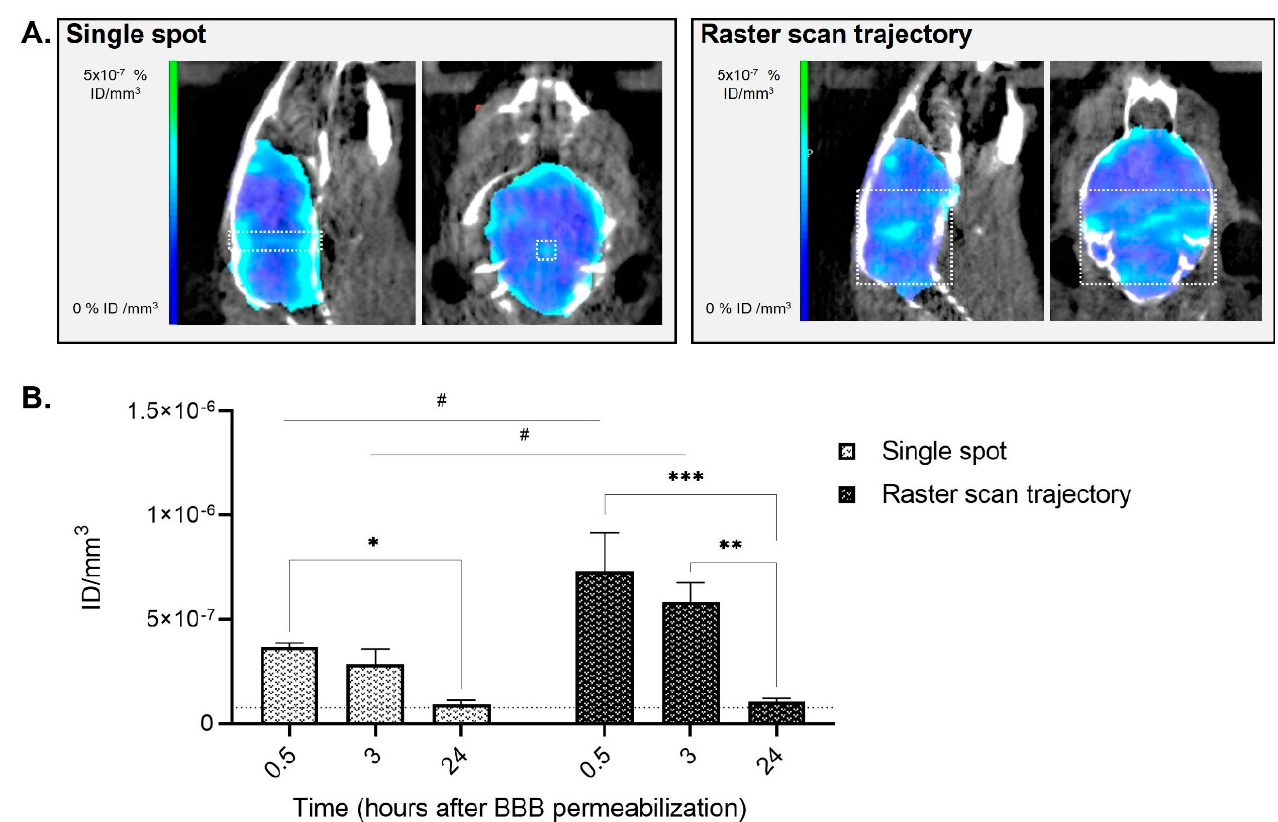
Figure 2. Imaging of the animal’s brain following BBB disruption and [99mTc]Tc-DTPA intravenous injection in healthy mice 0.5 h later. ( A ) Brain representative SPECT/CT tomographic images of [99mTc]Tc-DTPA distribution in animals that received single-spot (group A, left panel) or raster scan trajectory (group B, right panel) focused ultrasound. The white square represents the approximate region were FUS were applied for both sonication schemes; ( B ) Quantification of [99mTc]Tc-DTPA activity 0.5 h, 3 h and 24 h following focused ultrasound. Results are expressed as injected dose per tissue volume (ID/mm 3 ; n = 3; mean ± SEM). Statistical differences are reported as # for comparisons between single spot vs. raster scan trajectory and as * for comparisons between 0.5 h vs. 3 h vs. 24 h ( # p < 0.05; * p < 0.05; ** p < 0.01; *** p < 0.001). The black dotted line is a visual representation of the baseline of an animal that did not receive BBB permeabilization, obtained as an average of the 0.5 h, 3 h and 24 h [99mTc]Tc-DTPA quantifications of the sham animal (7.8 × 10 − 8 ± 1.6 × 10 − 8